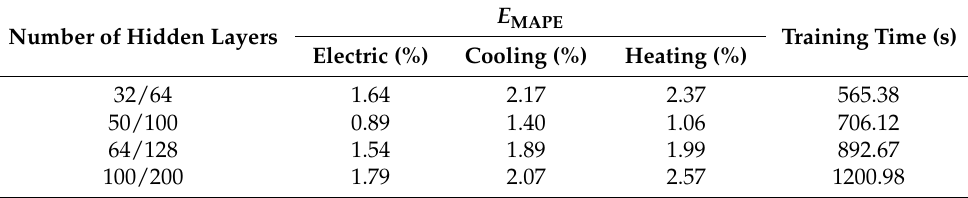
Table 5. Comparison of forecasting results of different numbers of neurons in 2 hidden layers. Number of Hidden Layers